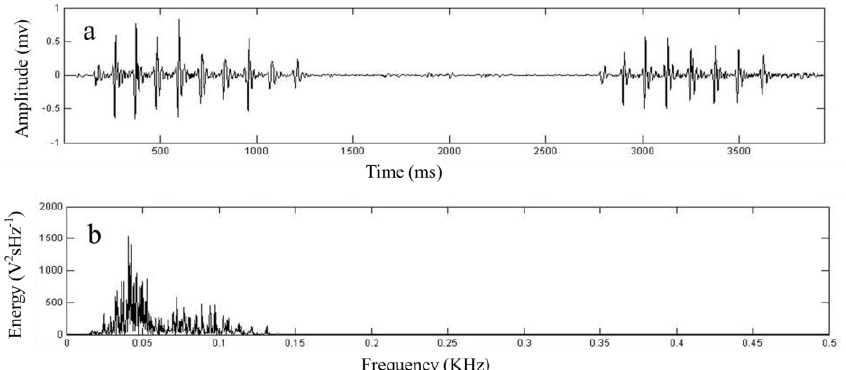
Figure 5. Seismic signal of plateau zokors in the experiments with artificial burrows ( a ) and Seismic signal amplitude FFT-Spectrum plots ( b ).